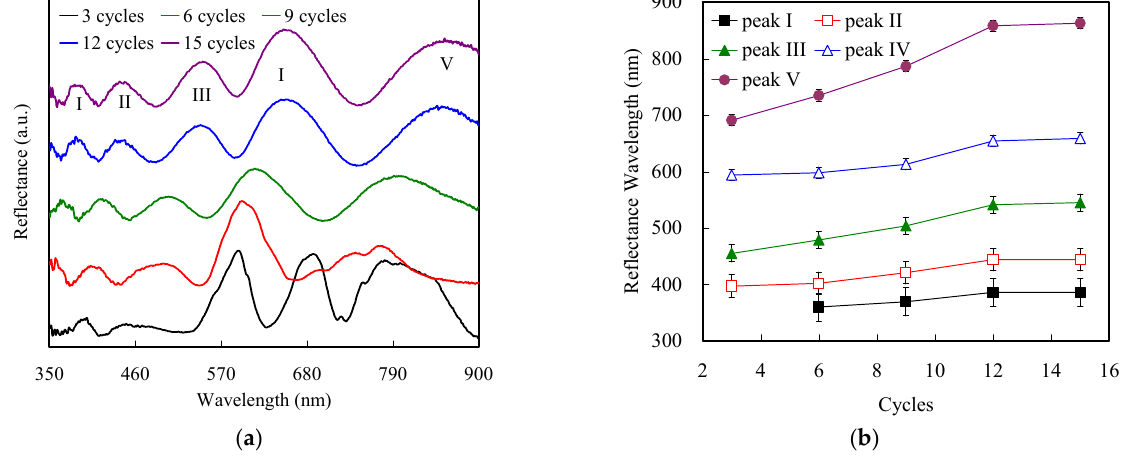
Figure 4. ( a ) Reflectance spectra of SPHR after 3–15 swelling/shrinking cycles used for AgC immobilization. ( b ) Wavelength of selected reflectance peaks determined for different numbers of swelling/shrinking cycles.